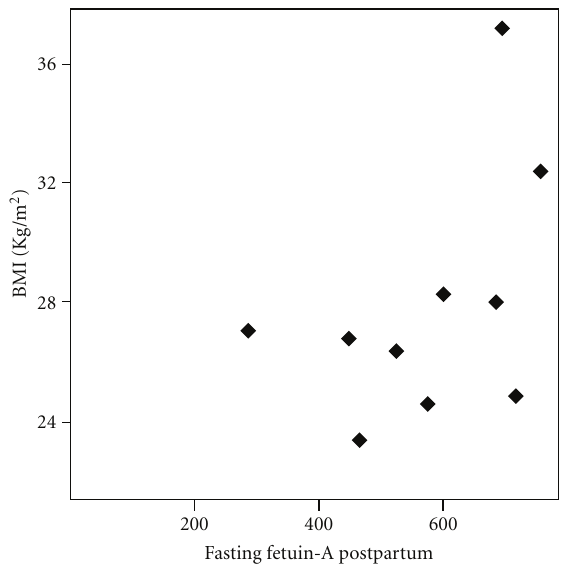
Figure 2: Scatter diagram of the correlation between fasting post- partum fetuin-A (ng/mL) and body mass index (BMI) (Kg/m 2 ) in women with history of gestational diabetes mellitus ( r = 0 . 90, P < 0 .